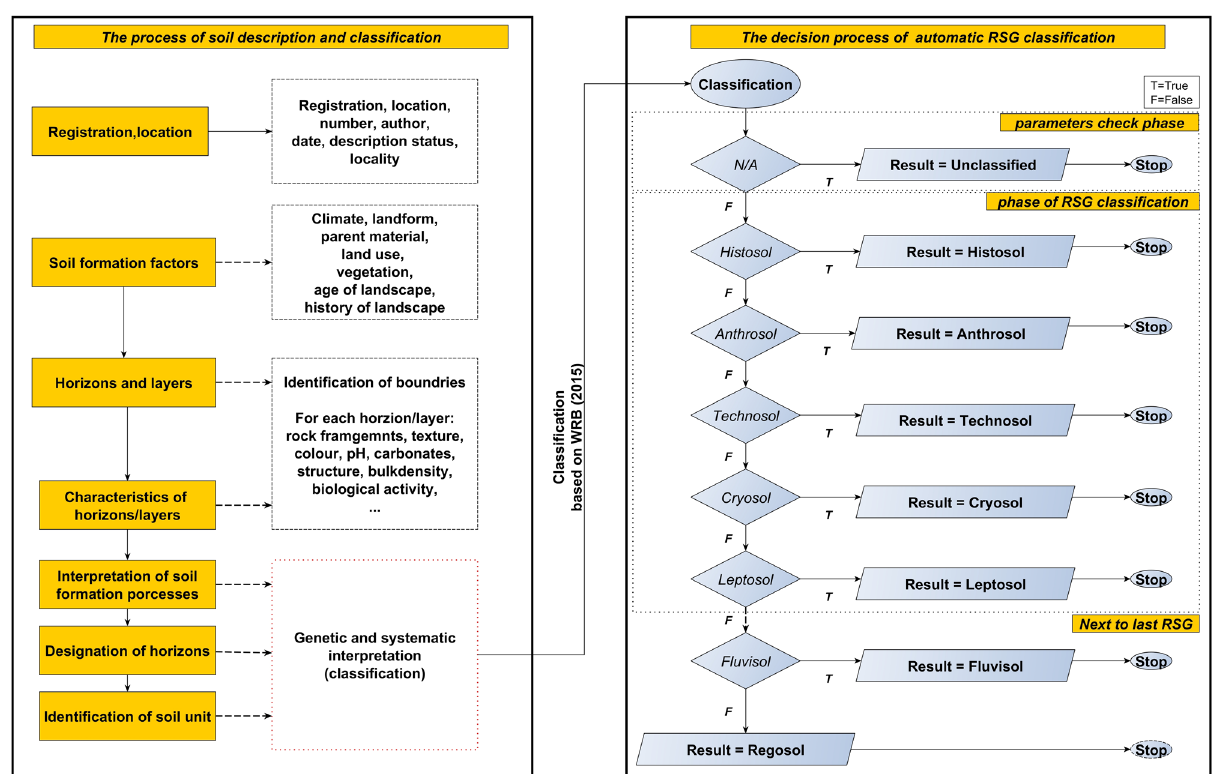
Figure 20: Process of soil description and automatic classi fi cation based on WRB 2014 ( 2015 update )